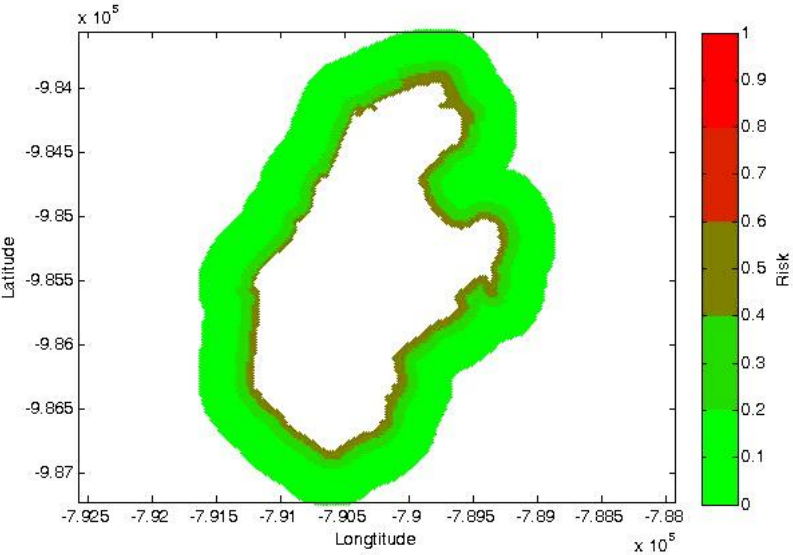
Figure 5. Risk map for Lake Most. Only a zone approximately of 75 m is dangerous for sectors one and two; in the third sector this zone is extended to 100–125 m and lastly in the fourth sector it is limited to 25–50 m.